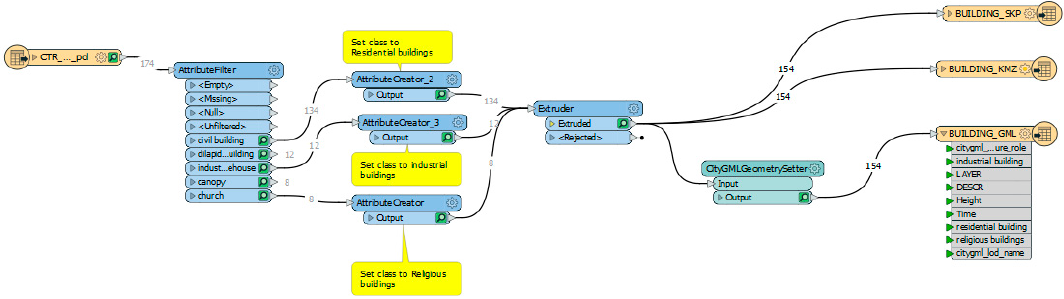
Figure 17 . Transformation schema in FME environment to obtain the “building” feature in CityGML format. CityGML